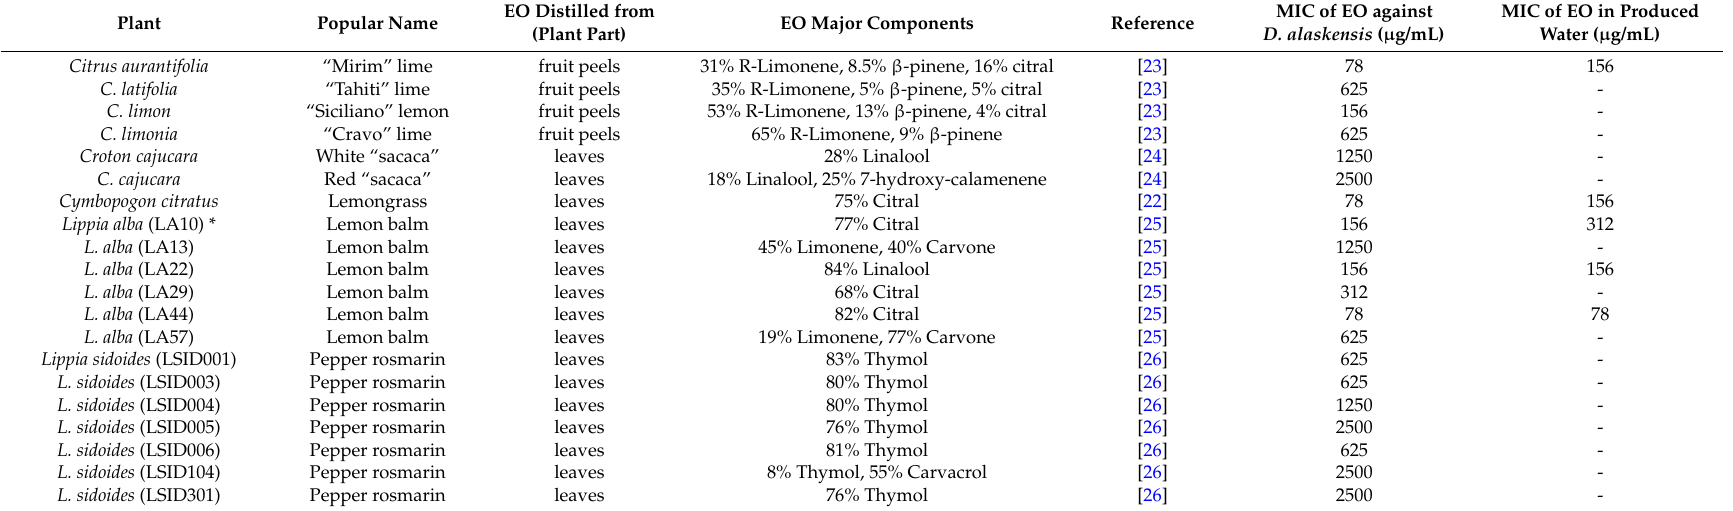
Table 2. Determination of the minimum inhibitory concentration (MIC) of essential oils (EO) against Desulfovibrio alaskensis NCIMB 13491 and against sulfate-reducing bacteria (SRB) growth in produced water